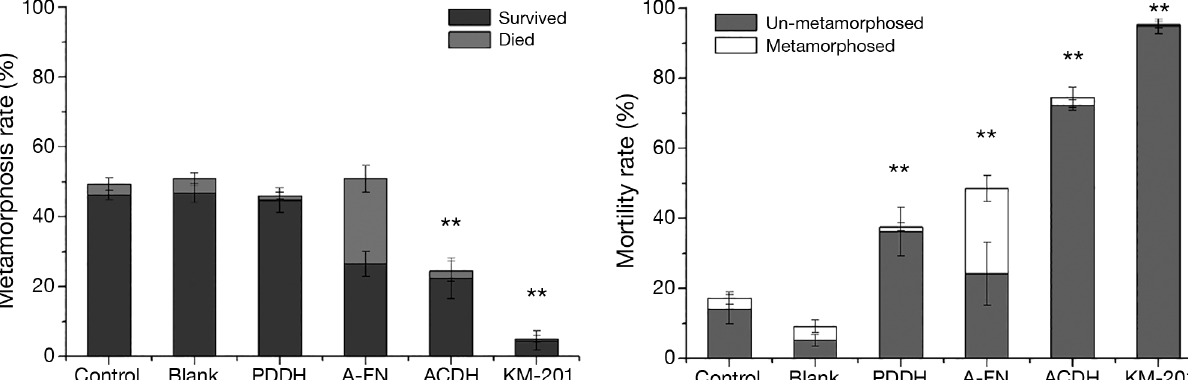
Fig. 2. Mean percentage of metamorphosed and un- metamorphosed abalone Haliotis discus hannai larvae which had been killed at 96 h when treated with toxic algae. Vertical bars represent SD and asterisks denote significant differences in mortality from controls. See Fig. 1 for further